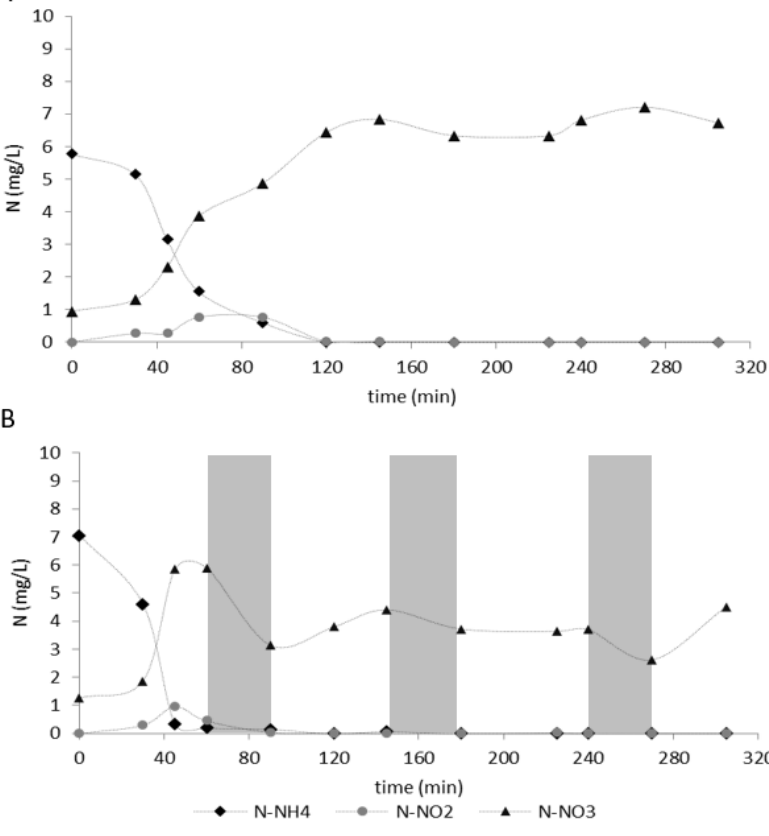
Figure 5. Concentration of ammonium, nitrite and nitrate during the cycles of ( A ) R 1 and ( B ) R 2 . Gray shading indicates phases without aeration.